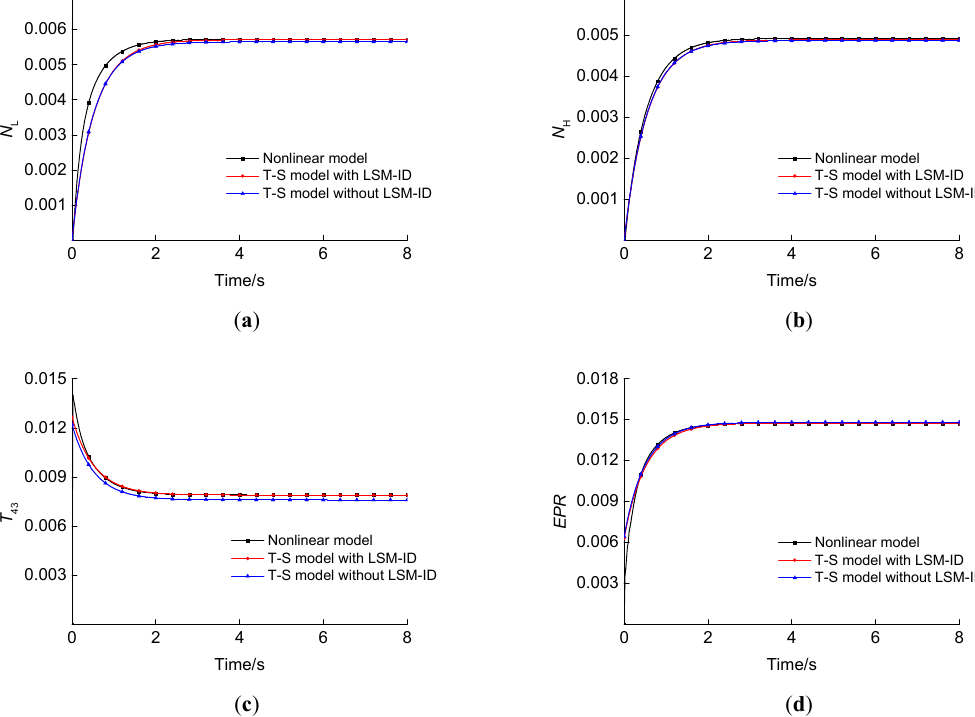
Figure 7. Response comparison under 2.5 km and 0.5 Mach. ( a ) N L response comparison. ( b ) N H responses. ( c ) T 43 responses. ( d ) EPR responses.